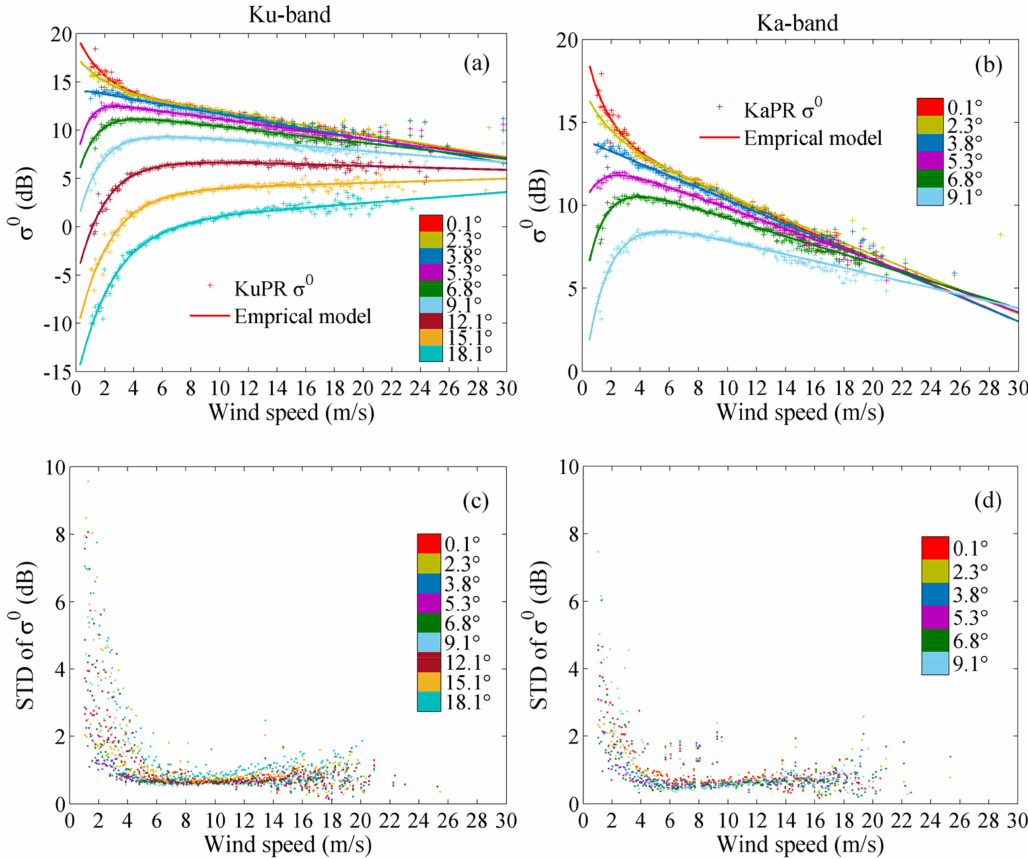
Figure 4. Mean values and standard deviations of binned KuPR ( a,c ) and KaPR ( b,d ) σ 0 as functions of wind speed for selected incidence angles. Solid lines are the empirical model